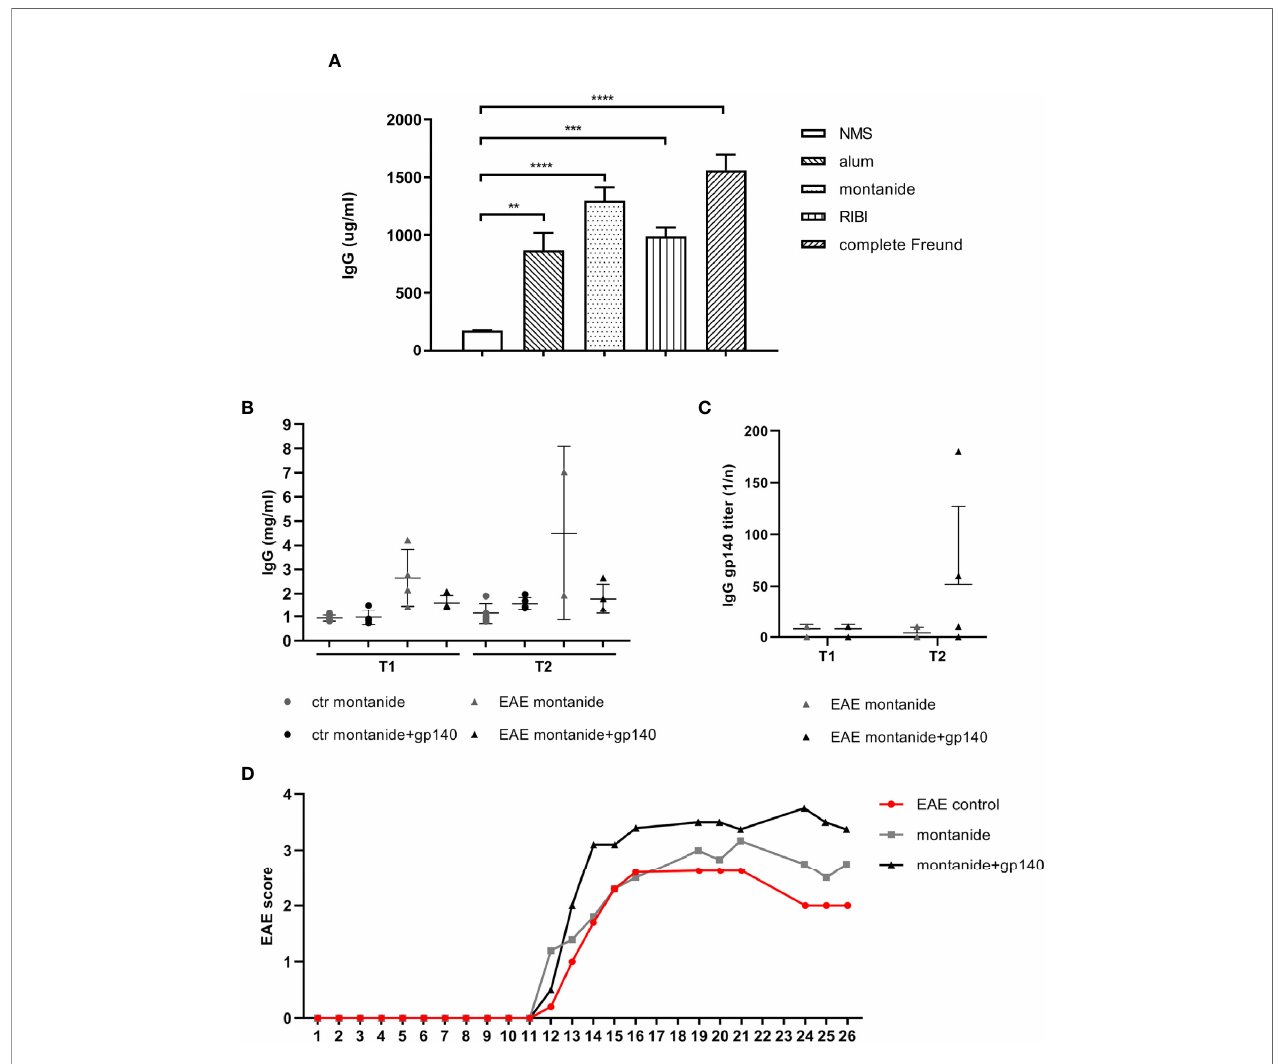
FIGURE 2 | (A) Total IgGs serum concentrations obtained with 4 different adjuvants in C57BL/6 mice (n = 5). C57BL/6 healthy or EAE mice were immunized with montanide alone (n = 5) or in combination with gp140 (n = 5). Total IgGs serum concentration expressed as mg/ml (B) and gp140-speci fi c IgG titers expressed as 1/ n (C) measured by ELISA are shown at 7 days p.i. (T1) and 14 days p.i. (T2). (D) Clinical evaluation of the EAE score in all experimental groups. All data are reported as the arithmetic mean ± SEM. p-values were calculated using the one-way Anova test (**p < 0.01; ***p < 0.001; ****p <